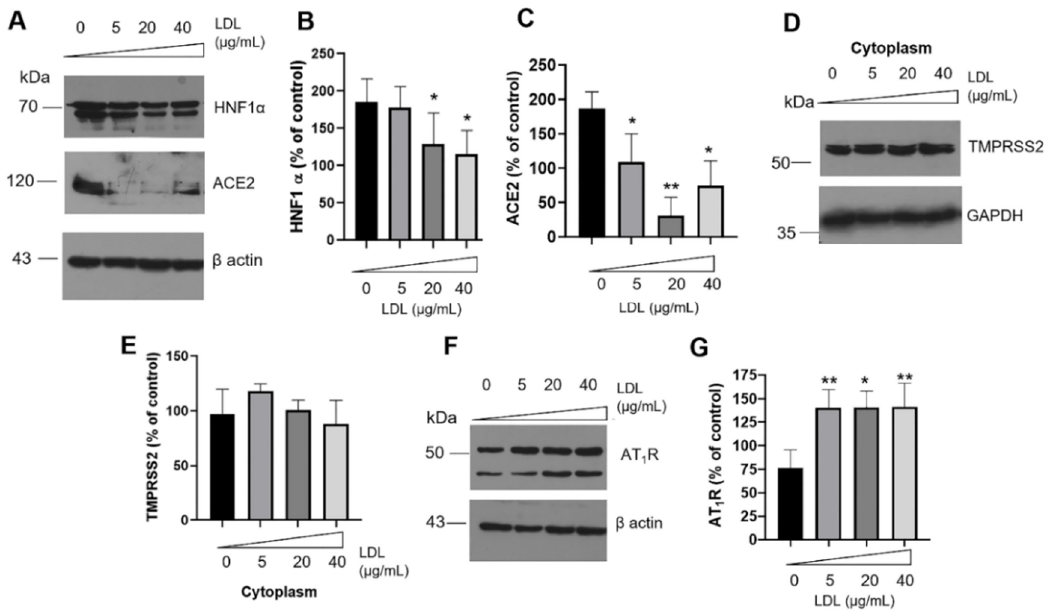
Figure 5. Effect of LDL treatment on renin–angiotensin system (RAS). ( A ) Western blot of HNF1α and ACE2 under increasing concentrations of LDL (0–40 µg/mL) at 20 h treatment. Quantitative characterization of HNF1α ( B ) and ACE2 ( C ), results are expressed as % of control, * p < 0.05, ** p < 0.005 ( n = 3, mean ± SD). ( D ) Under the same experimental condition, expression of TMPRSS2 on cytoplasm extracts; ( E ) densitometry analysis of TMPRSS2 ( n = 3, mean ± SD). GAPDH was used as a loading control. ( F ) AT 1 R expression levels under LDL incubation. ( G ) Densitometry analysis of AT 1 R, results are expressed as % of control, * p < 0.05, ** p < 0.005 ( n = 3, mean ± SD). In panels ( A , F ), β-actin was used as a loading control.